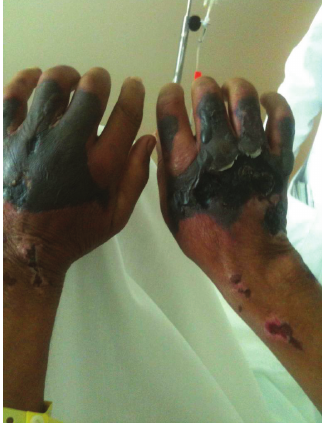
Figure 4: Necrotic lesions with erythematous base.